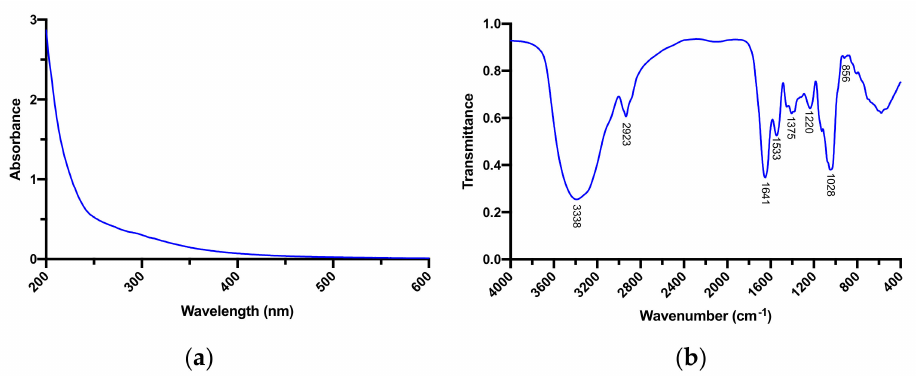
Figure 1. Structural characterization of LP-EPS: ( a ) UV absorption peaks of LP-EPS in the range of 200–600; ( b ) IR spectrum of